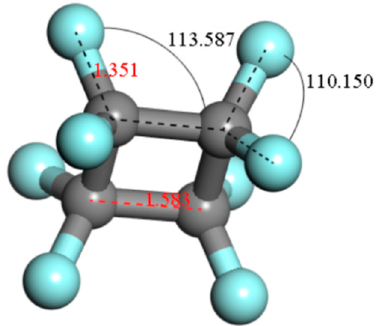
Figure 6. Molecular structure of c-C 4 F 8 .